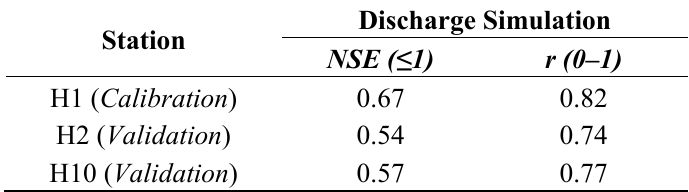
Table 2. Performance evaluation statistics of discharge simulation.